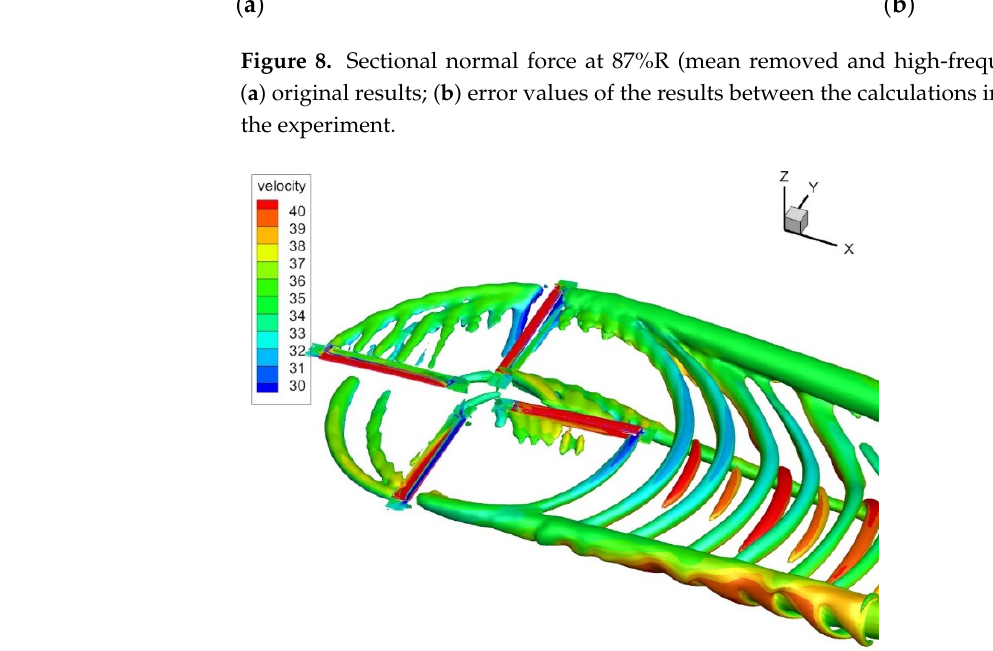
Figure 9. Iso-surface of the Q-criterion, colored according to velocity magnitude.